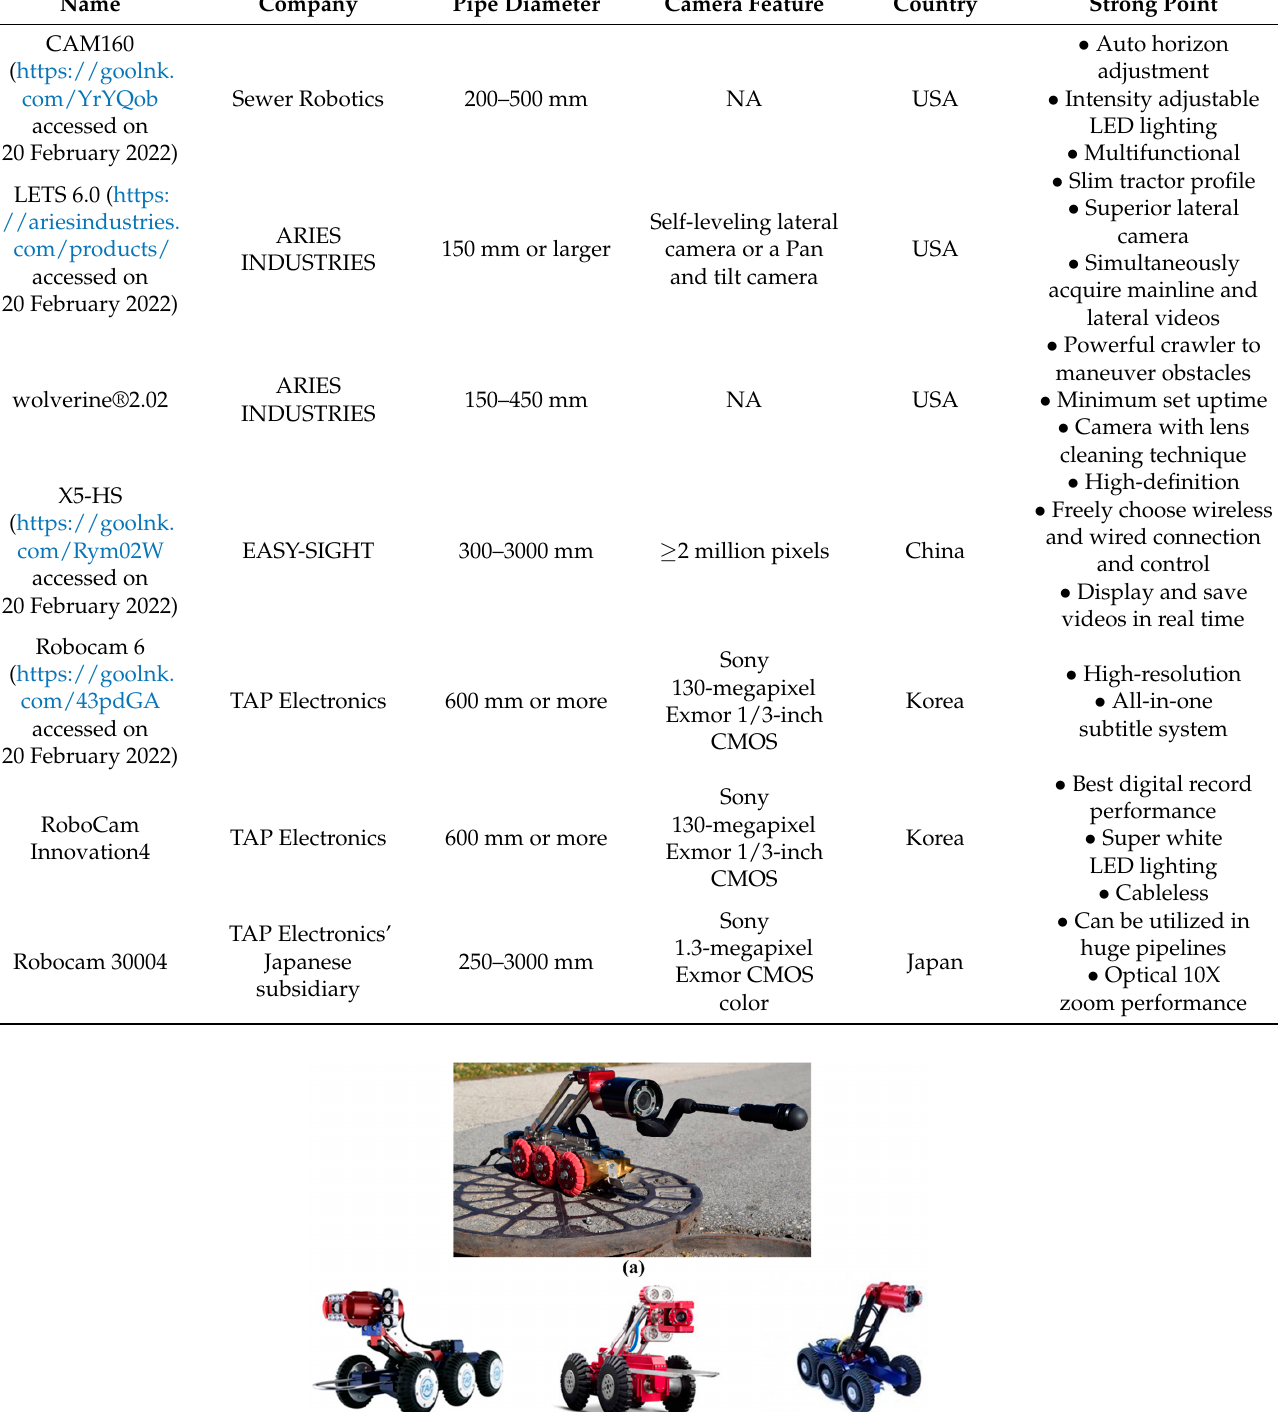
Table 5. The detailed information of the latest robots for sewer inspection.